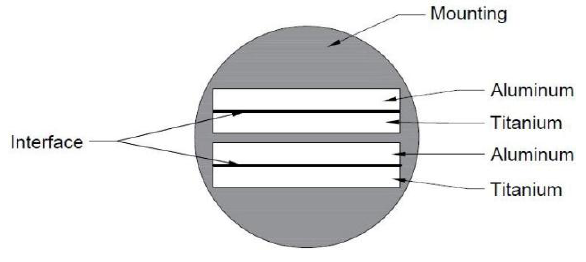
Figure 2. Samples mounted in bakelite.